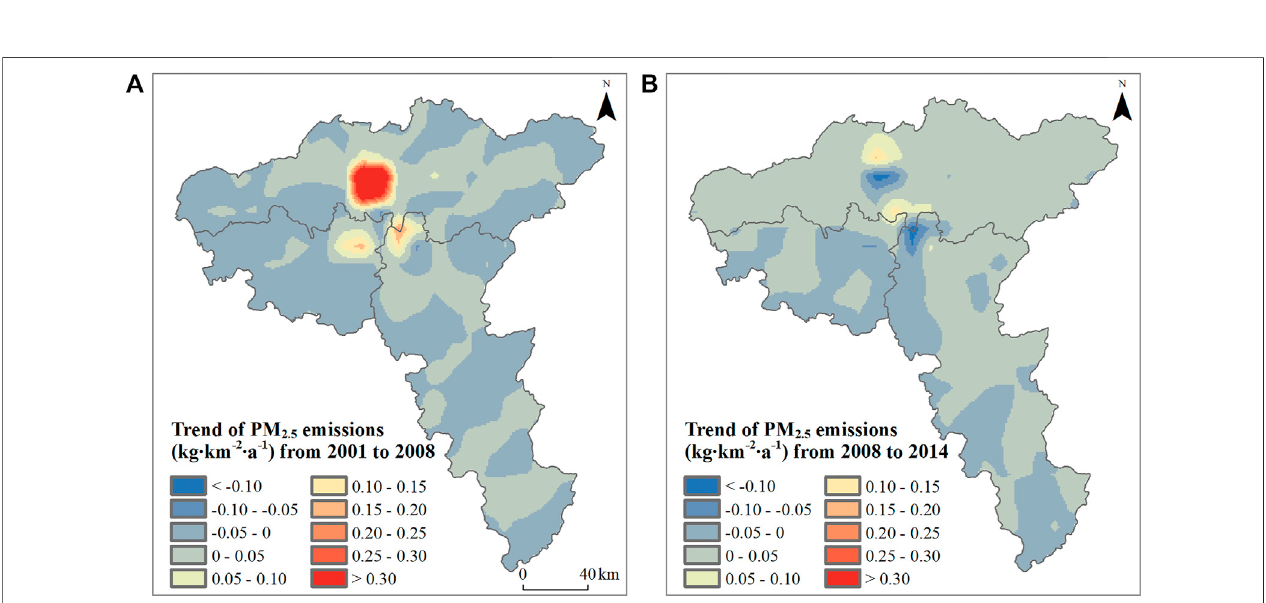
Frontiers in Environmental Science |